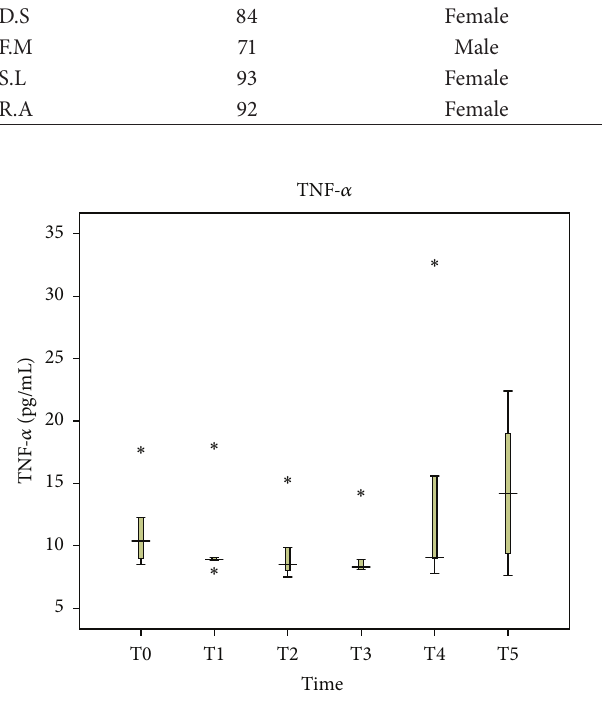
Figure 1: Perioperative tumor necrosis factor-alpha (TNF- 𝛼 ) levels in blood plasma.